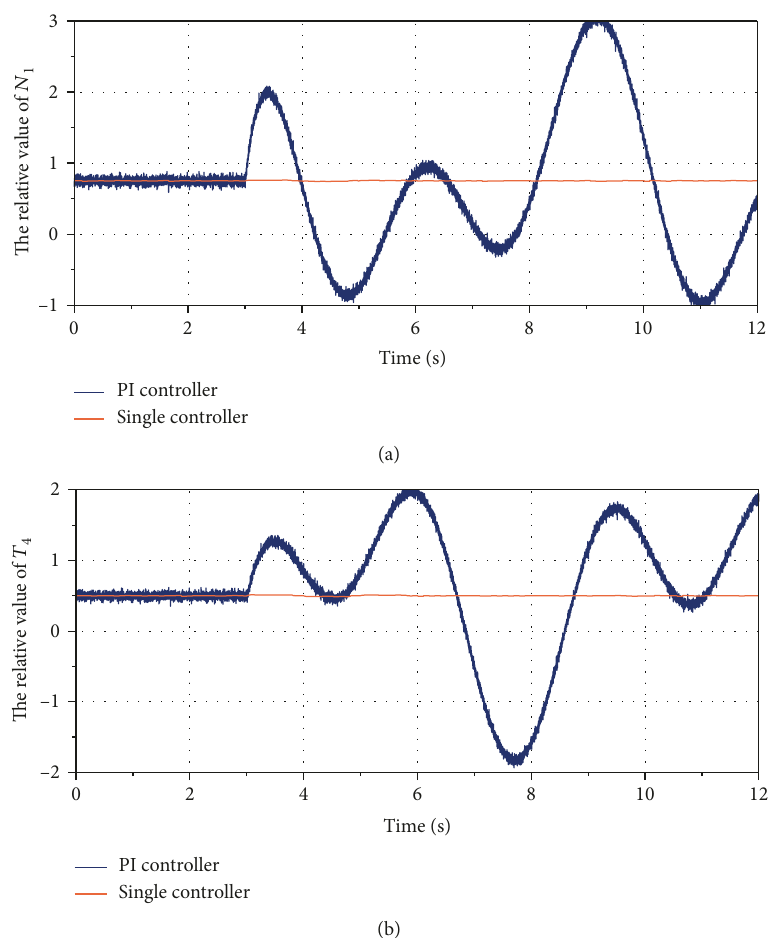
Figure 8: The simulation results of harmonic disturbance of steady state power management. (a) Low pressure rotor speed N (b) Turbine outlet temperature versus time (s).